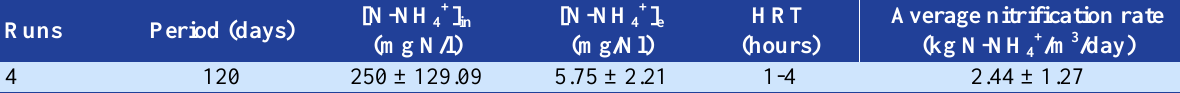
Table 1. Operational parameters for the nitrification granular activated carbon up-flow submerged reactors (NGAC-USR) throughout this study Runs HRT: Hydraulic retention